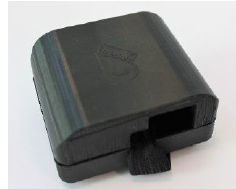
Figure 16. 3D-printed enclosure.